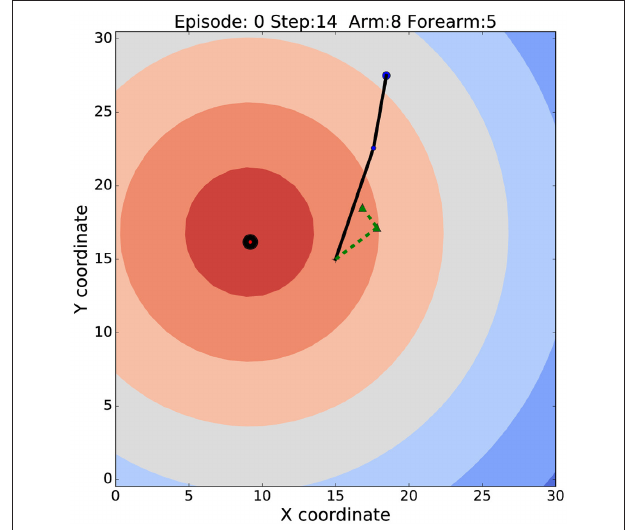
FIGURE 2 | The robotic arm set up in the environment. The solid black line indicates the robot arm. Blue and red circles display the end-effector and the target locations respectively. Colored contours illustrates reward function. Black circle shows the target zone. The dashed green line represents the internal model of the arm at very early stages of